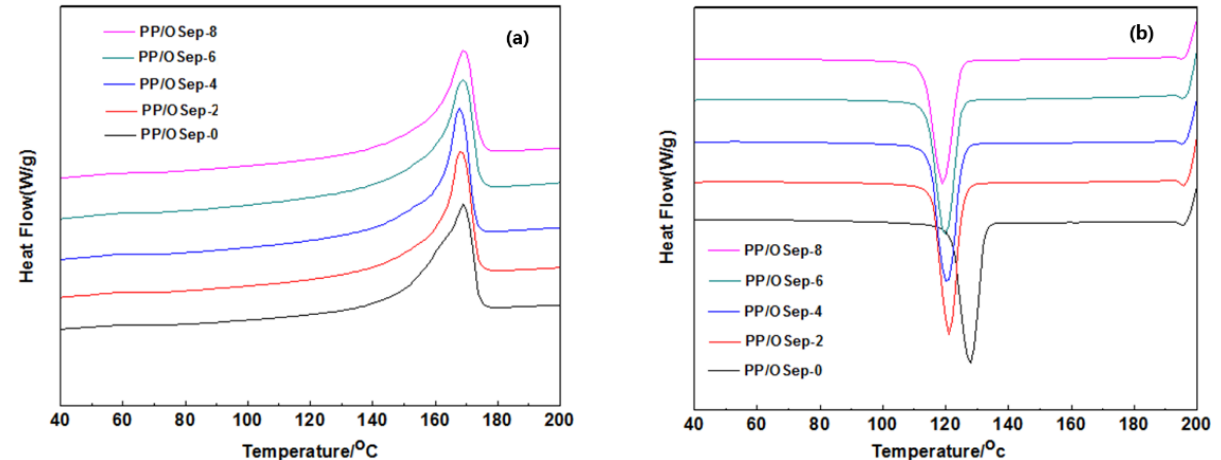
Figure 10. Second heating curves ( a ) and cooling curves ( b ) of PP/OSep nanocomposites with different OSep contents.